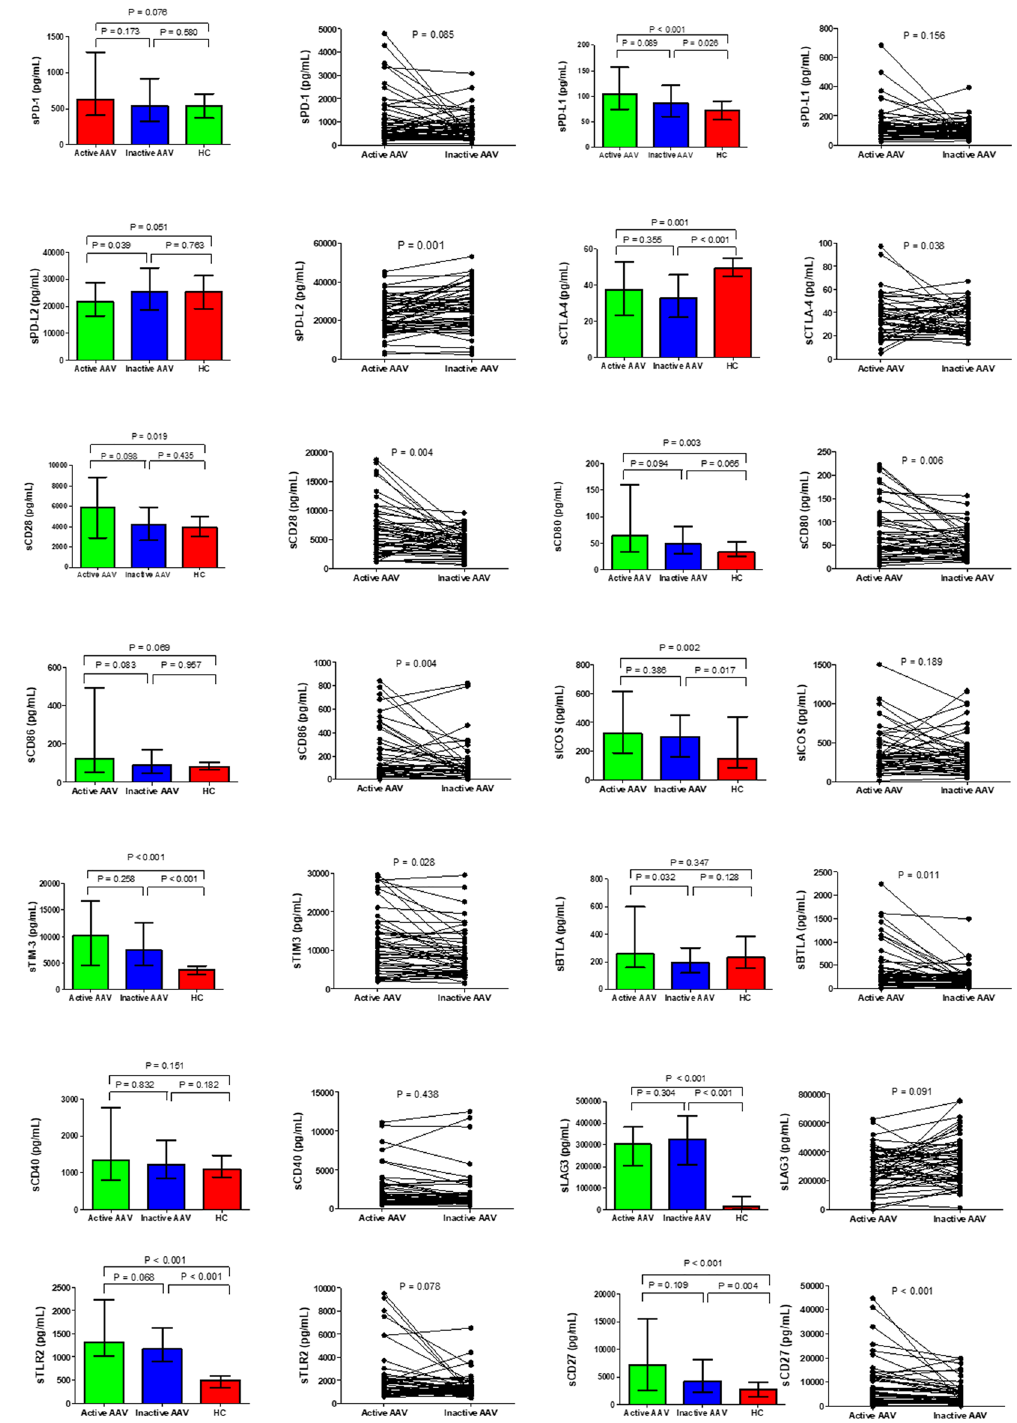
Figure 2. Serum concentrations of soluble checkpoint inhibitors in patients with active AAV, inactive AAV (after treatment), and healthy controls (HCs). Left side: median serum concentration with interquantile rage, Mann–Whitney U test applied for unpaired tests; Right side: paired samples for the 56 same patients, Wilcoxon signed-rank test applied. Plots show median, with error bars indicating ± interquartile range. sPD Soluble programmed cell death, sPD-L Soluble programmed cell death ligand, sCTLA-4 Soluble cytotoxic T-lymphocyte antigen 4, sCD Soluble cluster of differentiation, sICOS Soluble inducible T-cell costimulatory, sTIM-3 Soluble T-cell immunoglobulin and mucin-domain containing-3, sBTLA Soluble B- and T-lymphocyte attenuator, sLAG-3 Soluble lymphocyte-activation gene 3, sTLR-2 Soluble toll like receptor